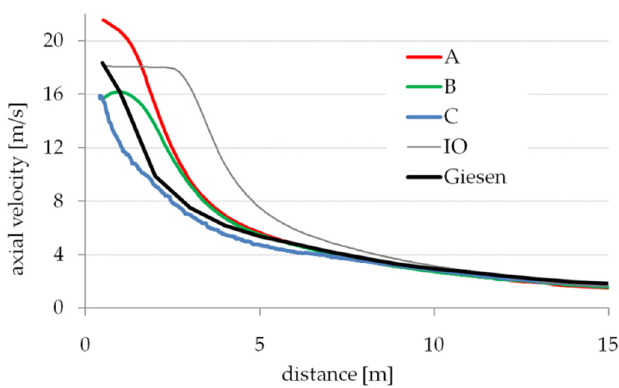
Figure 5. Axial velocity distributions along fan axis for examined fan models [19].